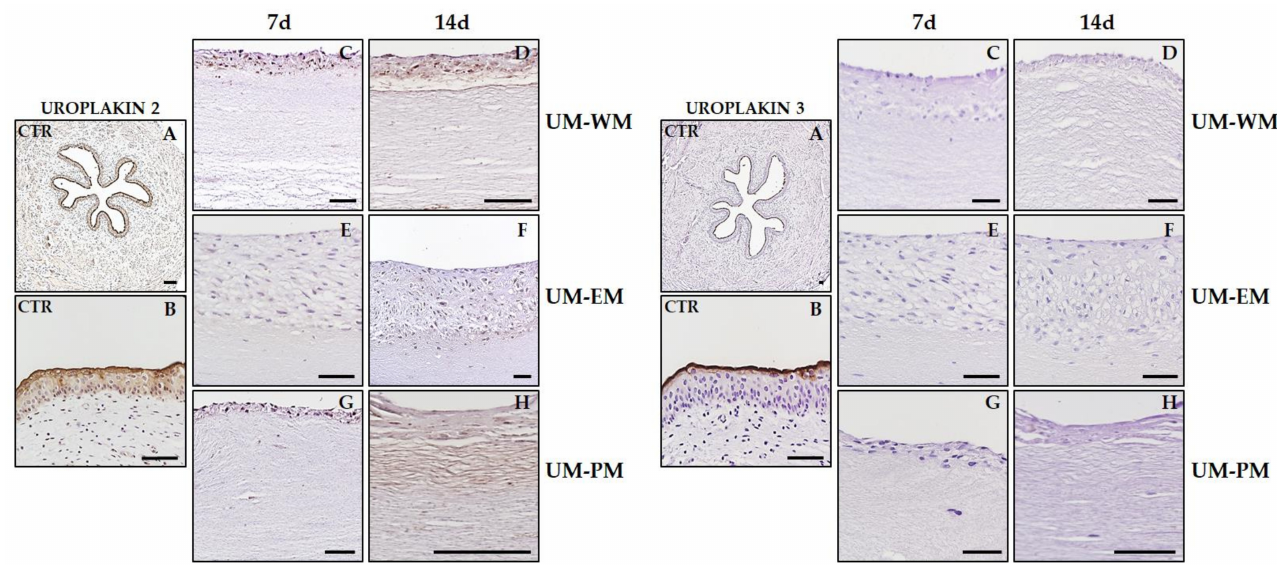
Figure 8. Immunohistochemical analysis of uroplakins 2 and 3 in control human UM (CTR) and tubularized heterotypical substitutes of the human UM cultured with three different media (WM, EM, and PM) for 7 and 14 days. Scale bars: 500 µ m in ( A ) and 100 µ m in ( B – H )